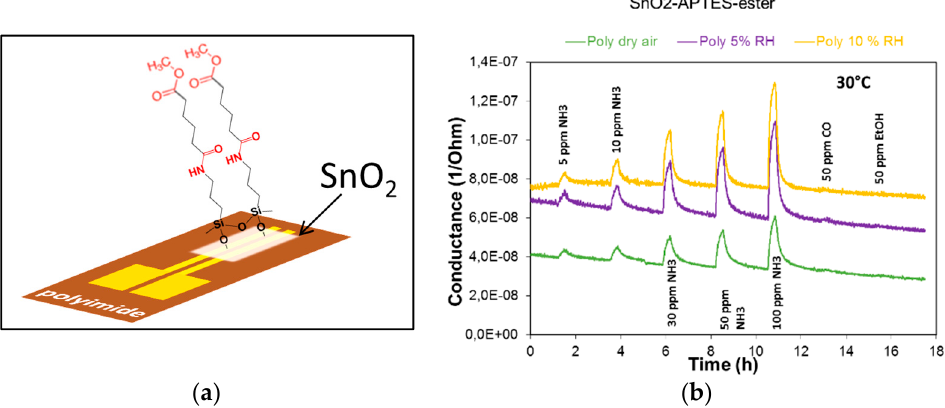
Figure 2. Functionalized SnO 2 sensor developed by inkjet on polyimide substrate: ( a ) schematic view of flexible sensor on polyimide with ester functionalized layer ( b ) Selective responses to NH 3 and influence of humidity at 30